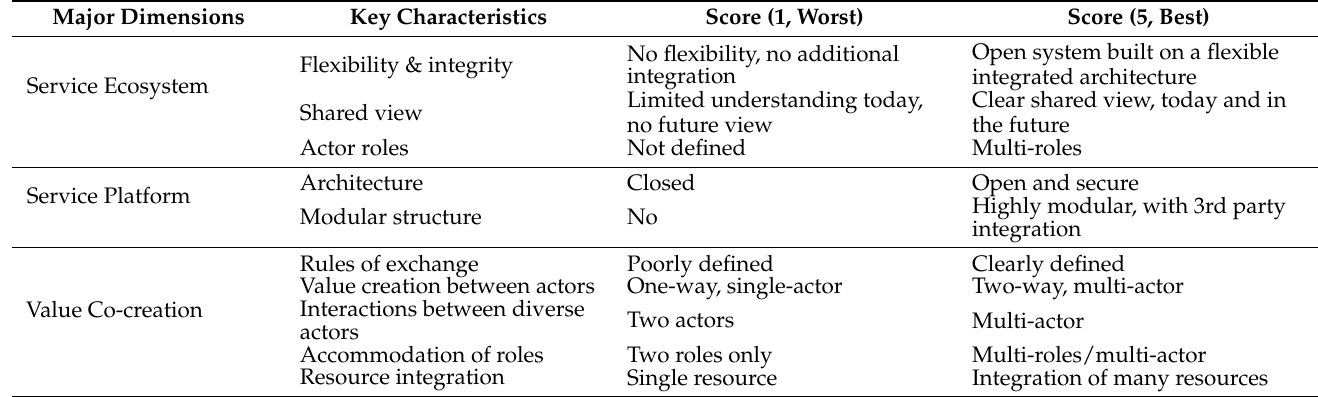
Table 2. Assessment of the value co-creation potential (West et al.